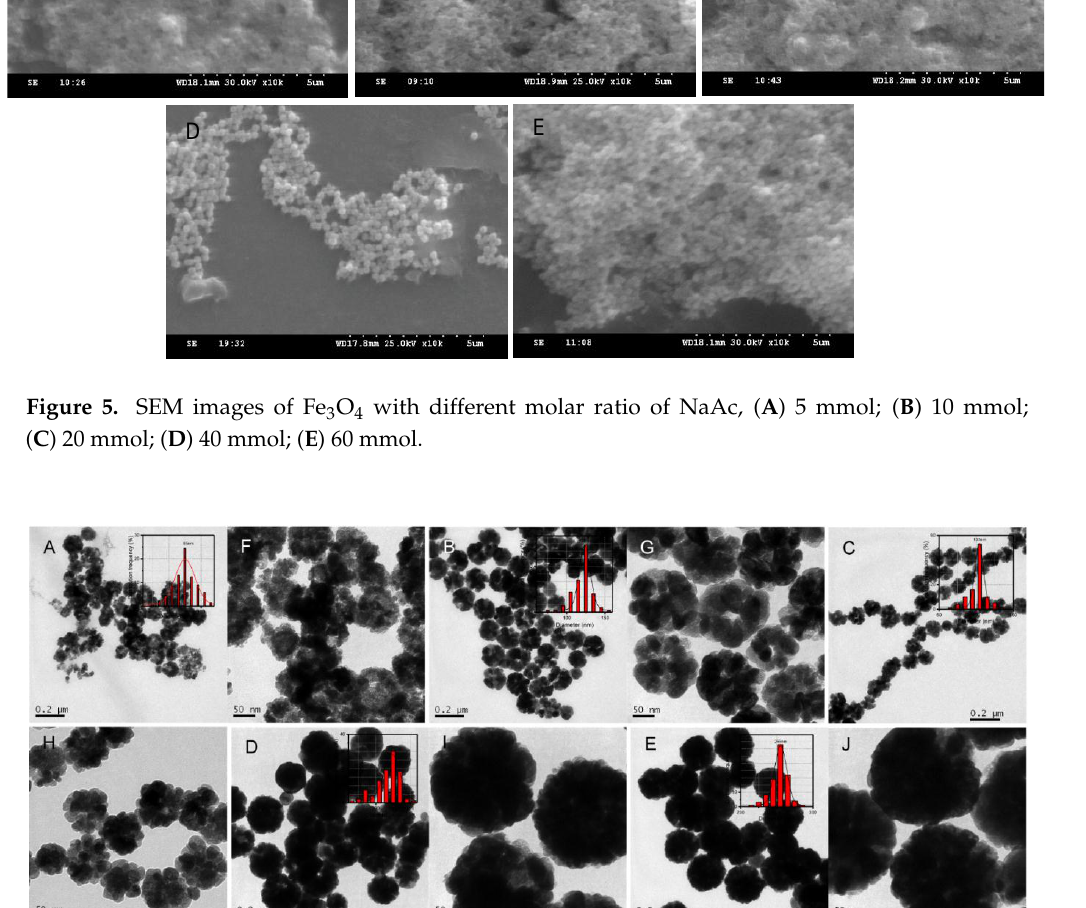
Figure 7. XRD patterns of Fe 3 O 4 obtained with different molar ratio of FeCl 3 ·6H 2 O, A: 0.4 mmol, B: 5 mmol, C: 10 mmol, D: 20 mmol. 20